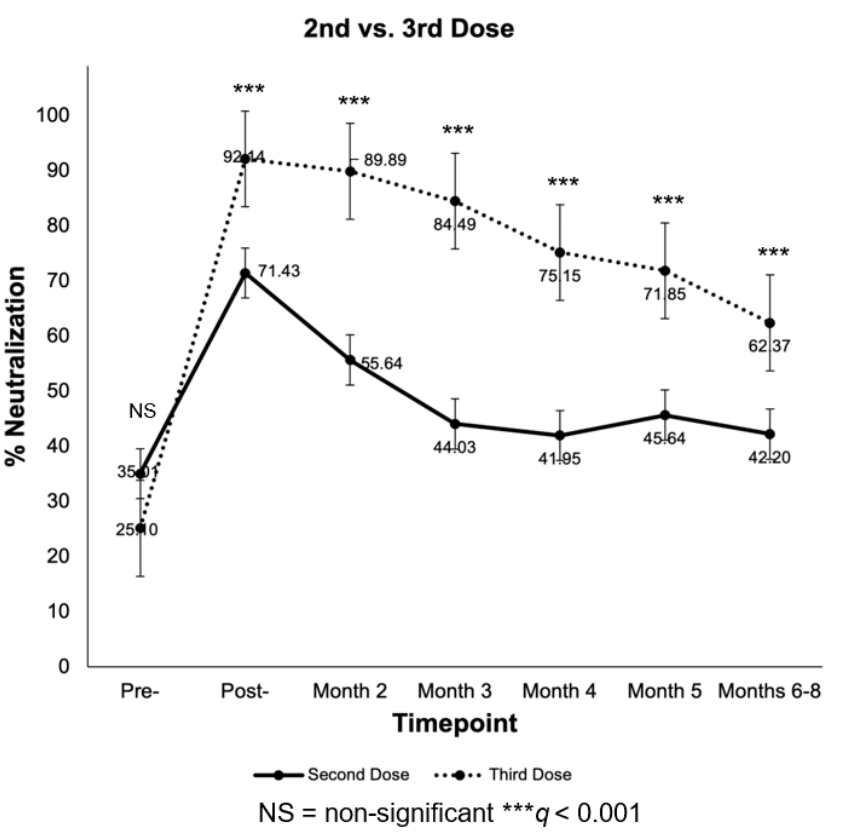
Figure 5. Line graph of measured percent neutralization between 2nd and 3rd vaccine dose recipi- ents from pre-2nd and -3rd doses to months 6–8 follow-up. Error bars represent standard error. Significance determined by Mann–Whitney U test; FDR-controlled q values shown.